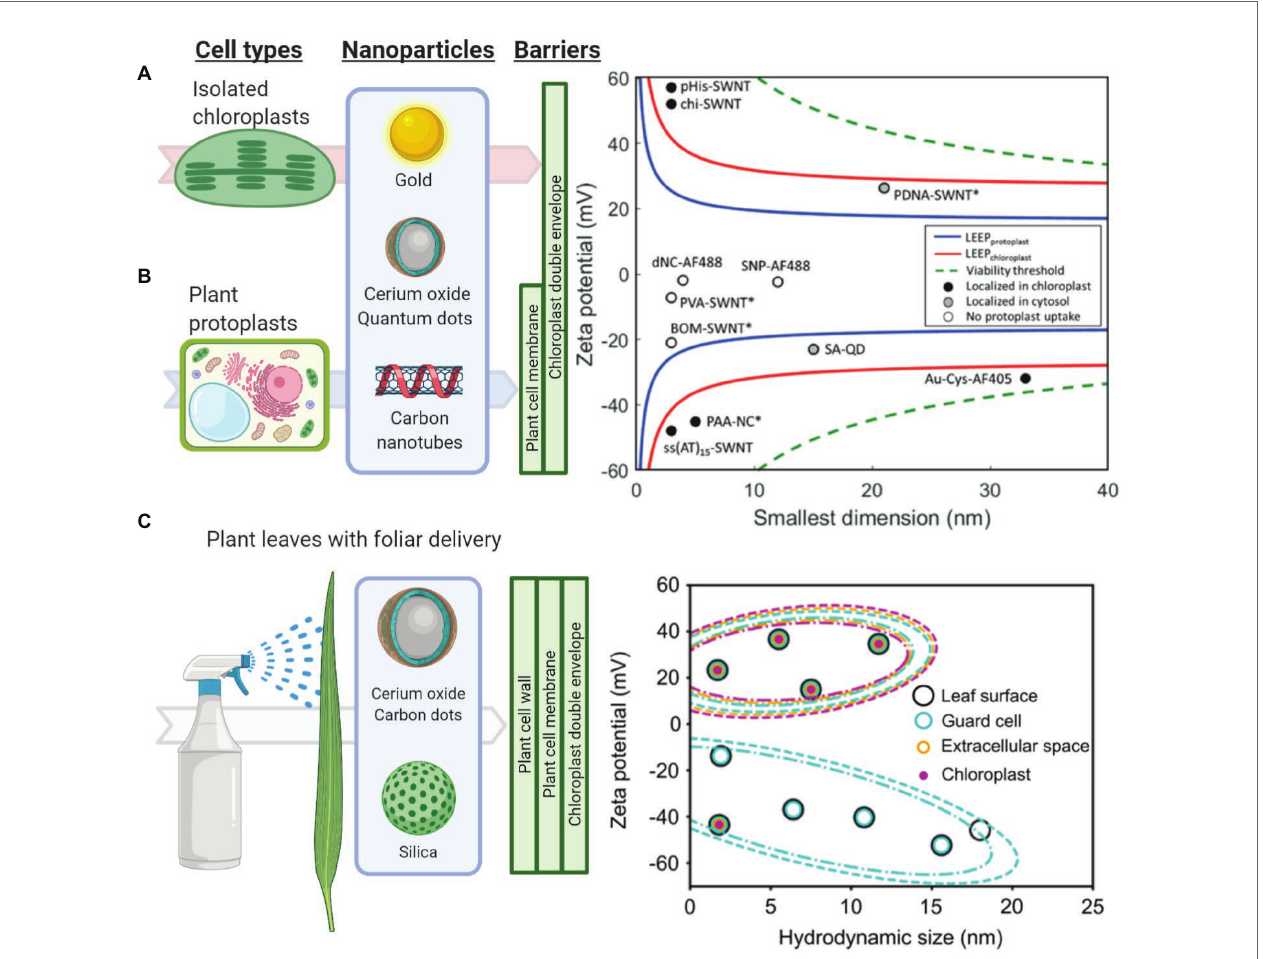
FIGURE 2 | Understanding and modeling nanoparticle-chloroplast interactions. (A) The lipid exchange envelope penetration (LEEP) model was developed on isolated plant chloroplasts. It predicts that highly charged nanoparticles localize within chloroplasts while more neutrally charged nanoparticles are unable to enter these organelles (Reprinted with permission from Wong et al., 2016). (B) Similarly, the LEEP model for isolated plant protoplasts that includes a plant cell membrane as a barrier, predicts that nanomaterial charge magnitude determines whether particles enter plant protoplasts or localize in the cytosol or chloroplasts (Reprinted with permission from Lew et al., 2018). (C) Systematic studies of foliar delivery of nanoparticles of various sizes and charges in planta indicated that there is a size limit for uptake in leaf cells in which highly positively charged nanoparticles were more efficiently delivered into these organelles (Reprinted with permission from Hu et al.,